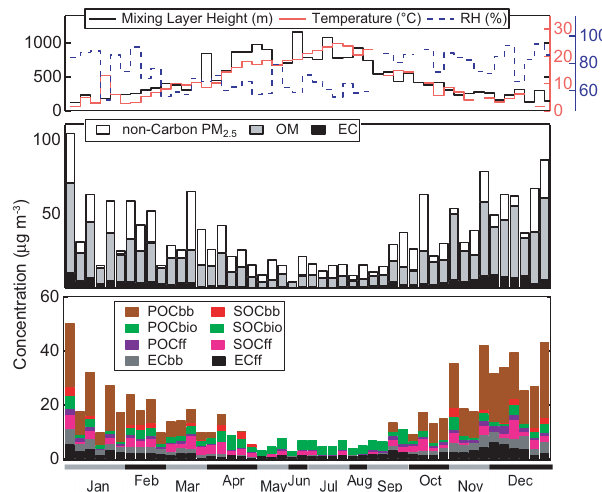
Fig. 3. Meteorological parameters (a) , contribution of OM and EC to PM 2 . 5 (b) , and best estimate results of source apportionment study (c) corresponding to the subset of daily aerosol samples here